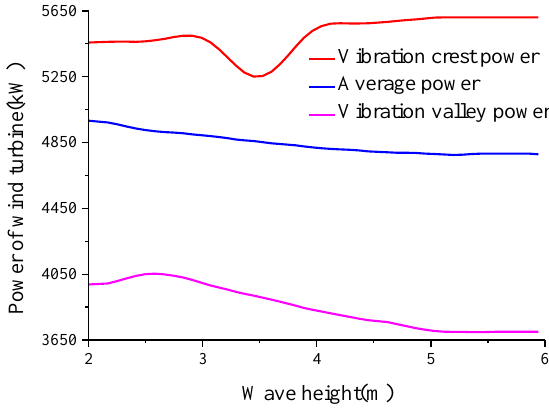
Figure 10. Comparison of the wind turbine power at different wave heights.